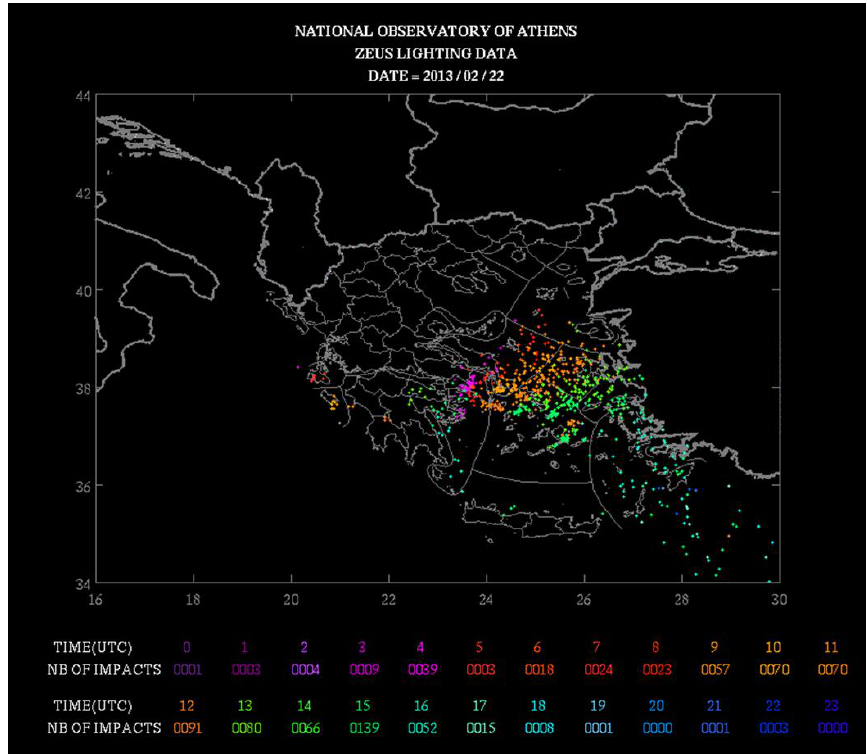
Figure A5. NOA ZEUS lightning data over Greece on 22 February 2013.